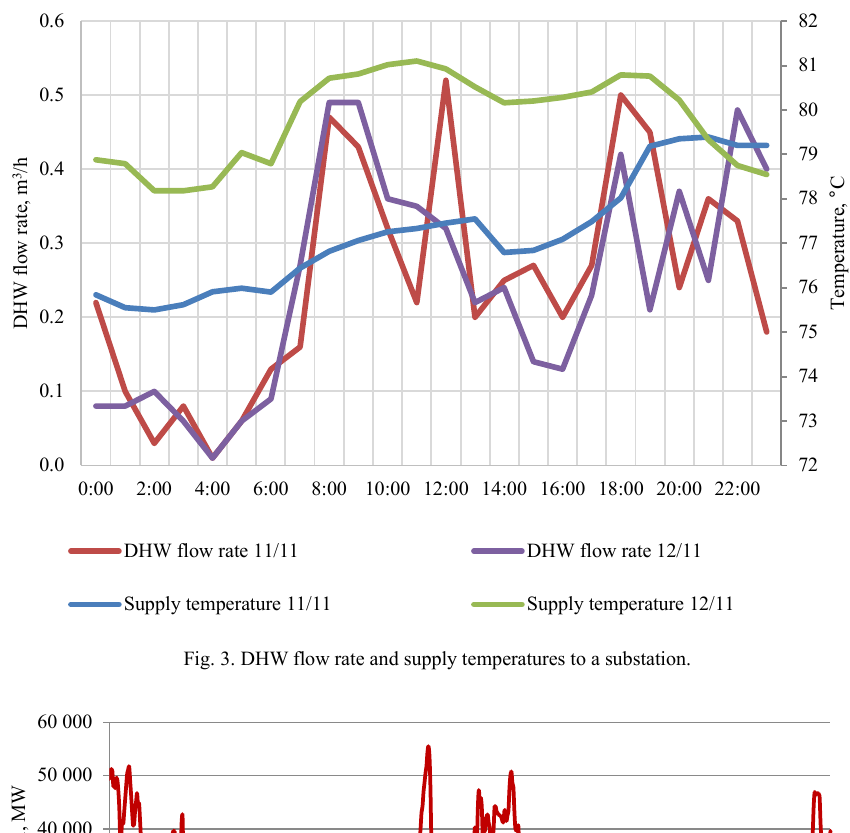
Fig. 3. DHW flow rate and supply temperatures to a substation.